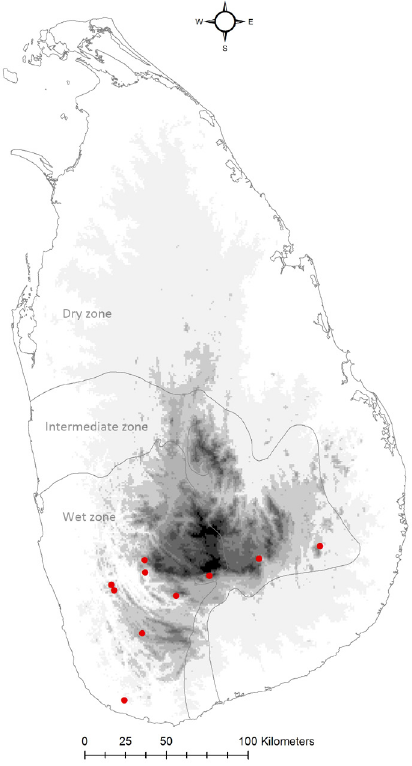
Figure 1. Distribution of N. pactolus ceylonica in Sri